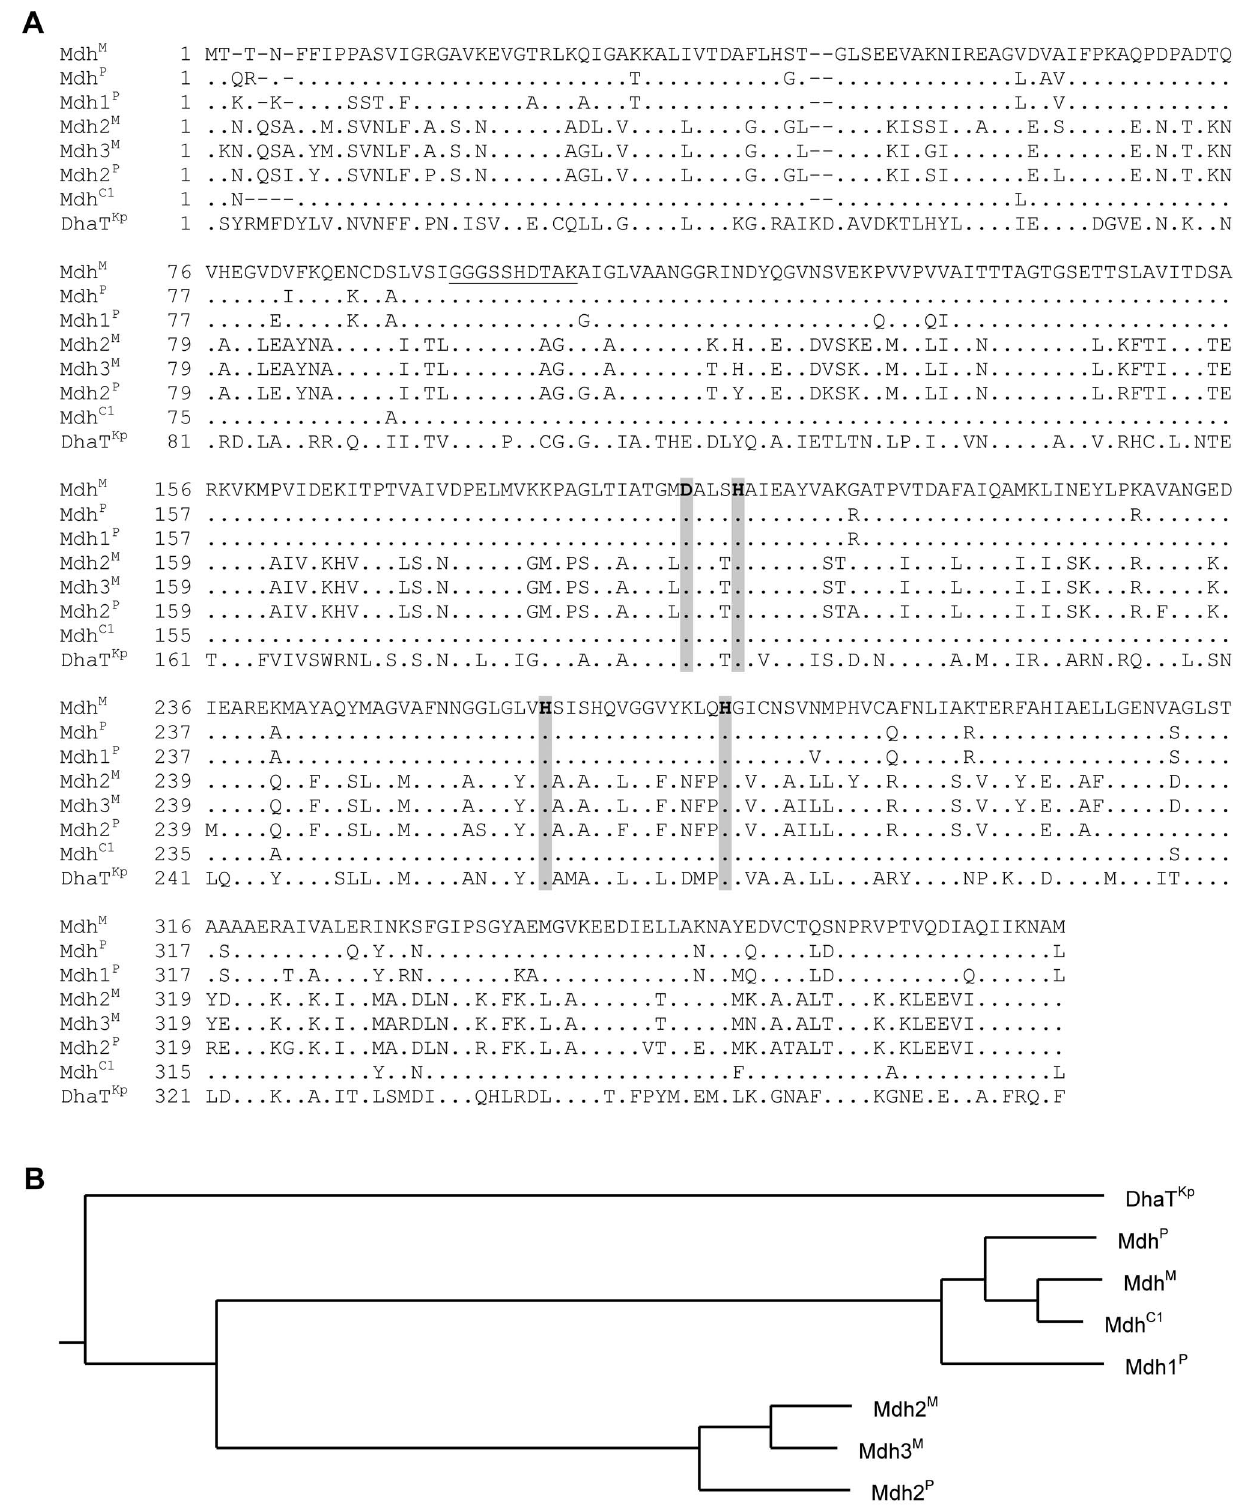
Figure 1. Comparison of the B.methanolicus Mdhs and the K.pneumoniae 1,3-PDH (DhaT Kp ). The MGA3 Mdhs are denoted Mdh M , Mdh2 M , and Mdh3 M ; the PB1 Mdhs are denoted Mdh P , Mdh1 P , and Mdh2 P , while the C1 Mdh is denoted Mdh C1 . ( A ) Primary sequence alignments show a conserved GGGSX 2 DX 2 K motif involved in NAD + binding (underlined) and residues assumed to be involved in metal ion binding (bold and highlighted). Residues in bold are unique for type III Adhs [12]. (B ) Relationship among the primary protein sequences of the B. methanolicus MGA3, PB1 and C1 Mdhs and the K. pneumoniae 1,3-PDH, represented by a phylogenetic tree.